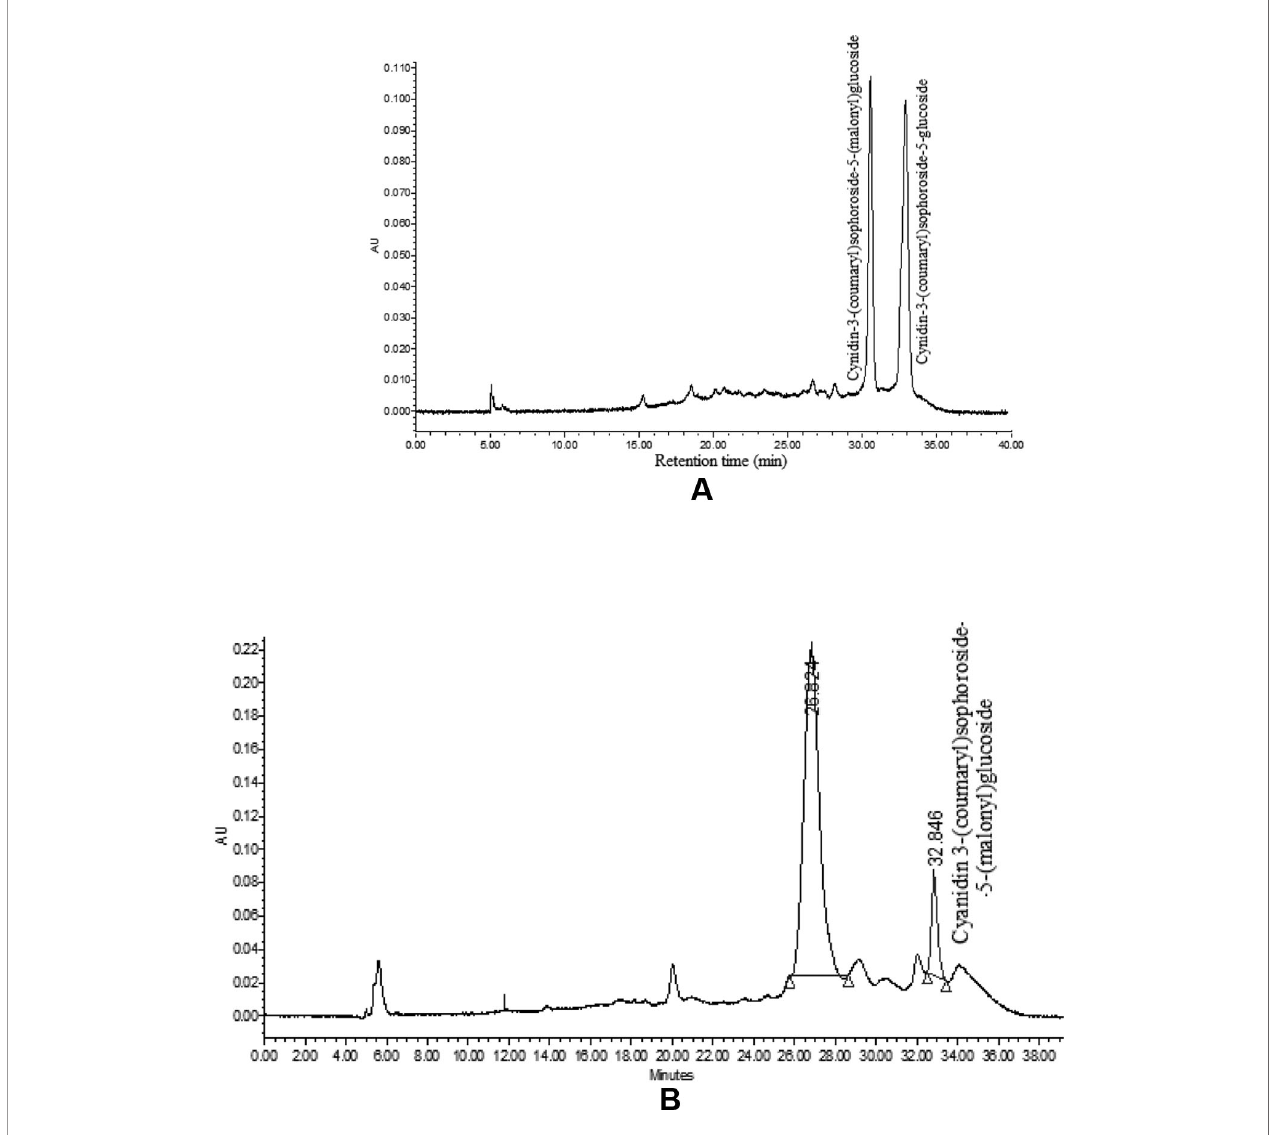
FIGURE 7 | HPLC chromatogram of anthocyanin in ‘ PC-1 ’ (A) and ‘ Graf fi ti ’ (B) .